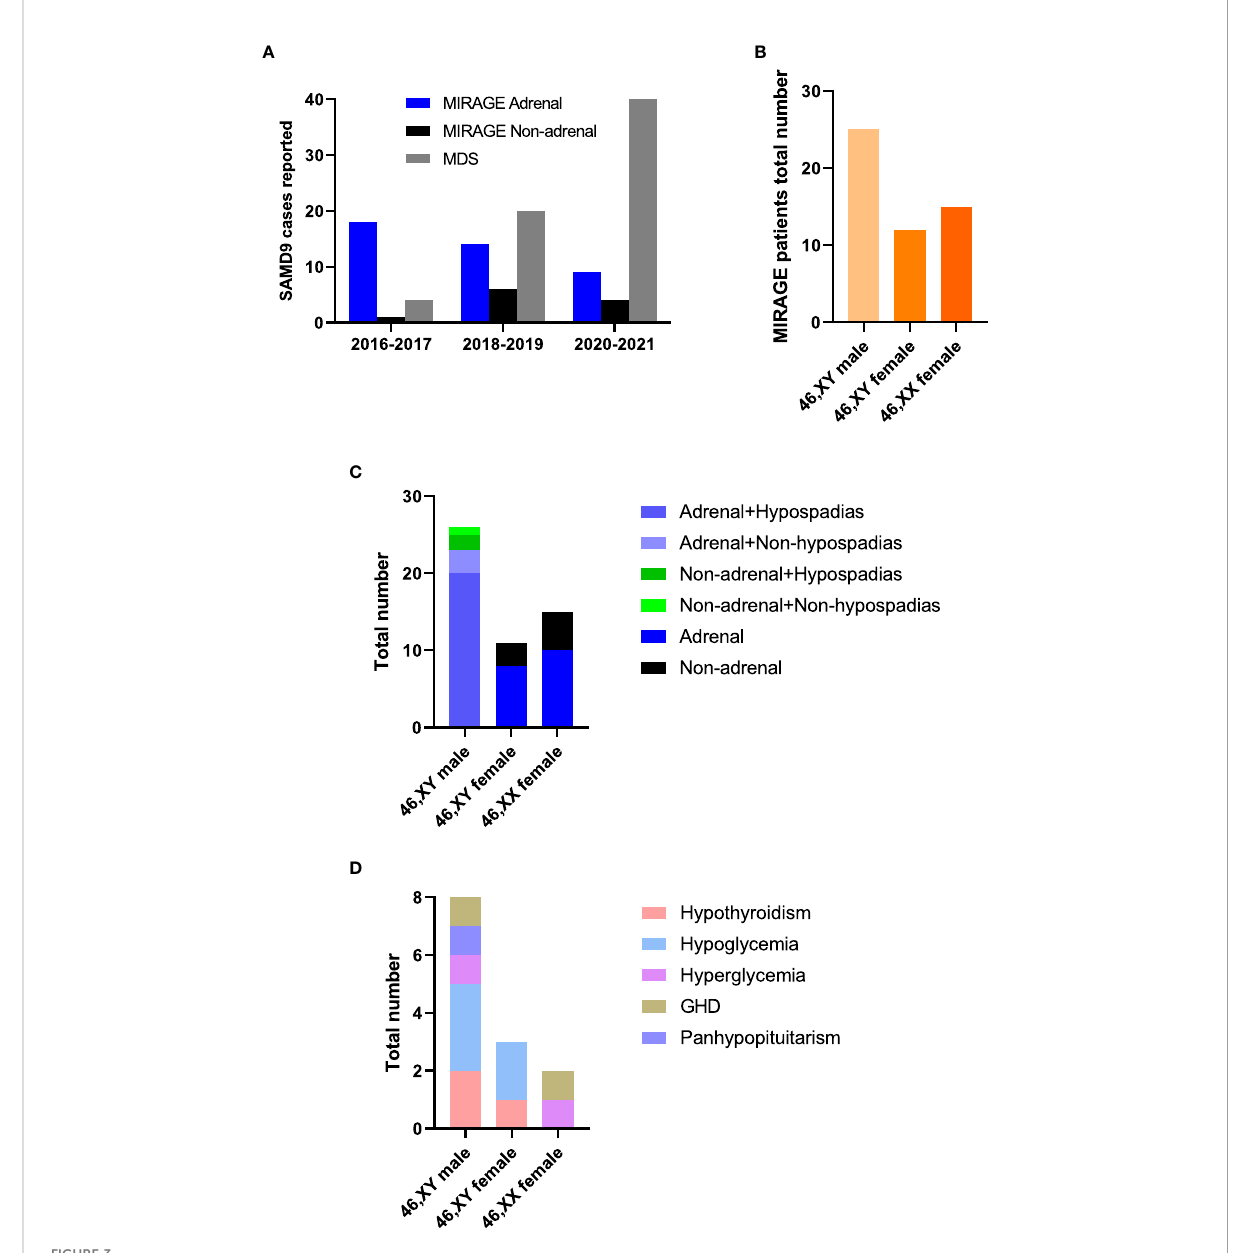
FIGURE 3 MIRAGE endocrine features. (A) Individuals with SAMD9 pathogenic variants reported from 2016 to 2021. (B) Total numbers of MIRAGE patients based on karyotype and reported sex assignment. “ 46,XY female ” indicates a 46,XY child who was brought up as a girl. (C, D) Endocrine features of children with MIRAGE syndrome, where reported. Data include two reported individuals with MIRAGE syndrome who developed endocrinopathies not originally described in the publication. GHD, growth hormone de fi